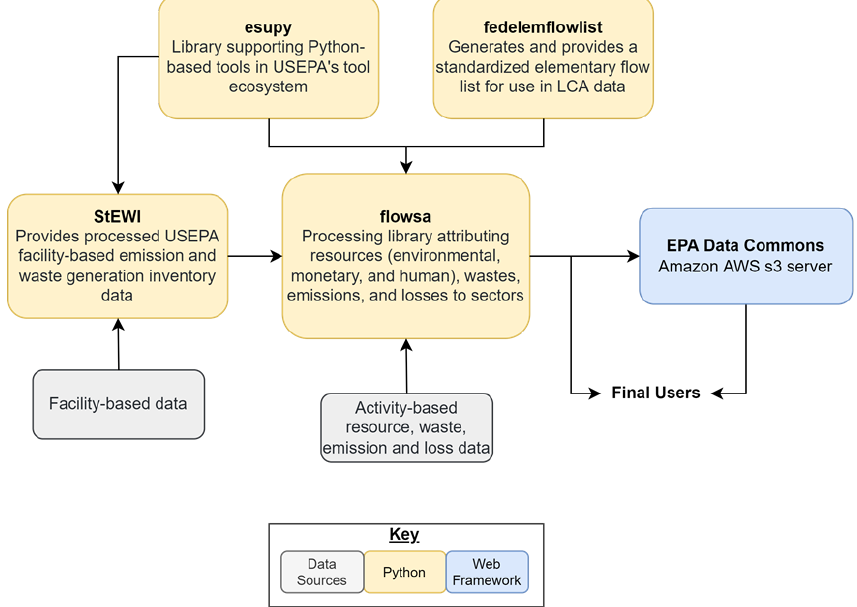
Figure 1. Schematic of the connections between FLOWSA and other USEPA life cycle assessment (LCA) ecosystem tools.